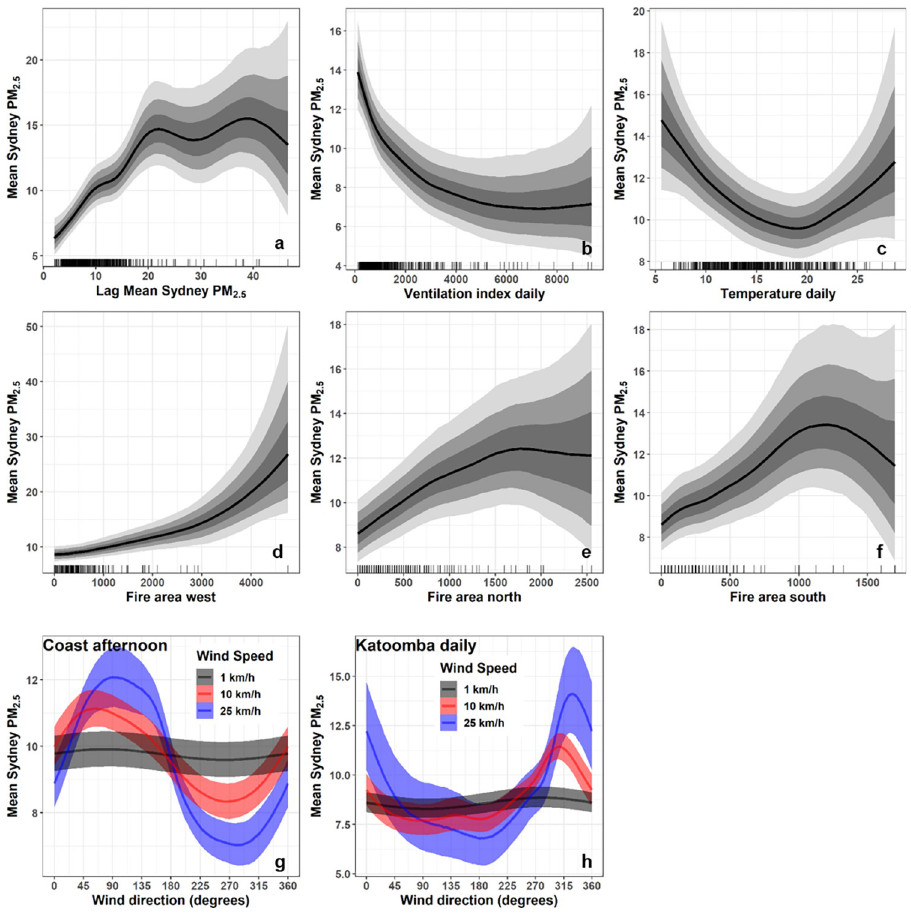
Fig 4. Bayesian mean effects plots for each variable for mean daily Sydney PM 2.5 model. The grey bands represent, from darkest to lightest grey, 0.5, 0.8 and 0.95 credible intervals. Effect of each fire area variable is shown with other two fire area variables held at zero. Other variables held at mean values. U and V wind components have been converted to wind speed and direction effects (bands show 0.5 credible interval). Wind directions are standard wind direction in degrees, i.e. 180 = southerly